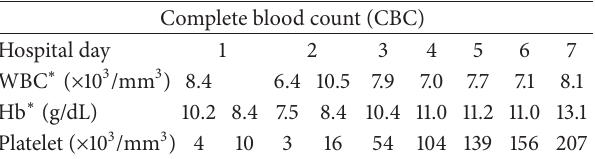
Table 1: Complete blood counts during